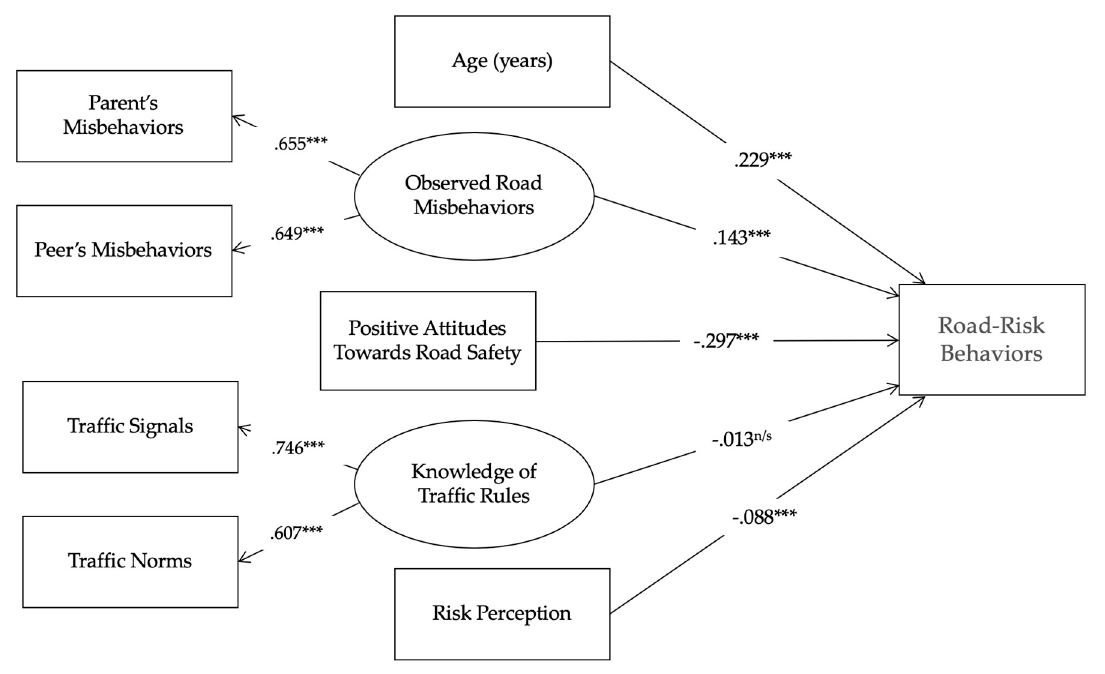
Figure 1. Path structural model showing standardized path coefficients for self-rated Risky